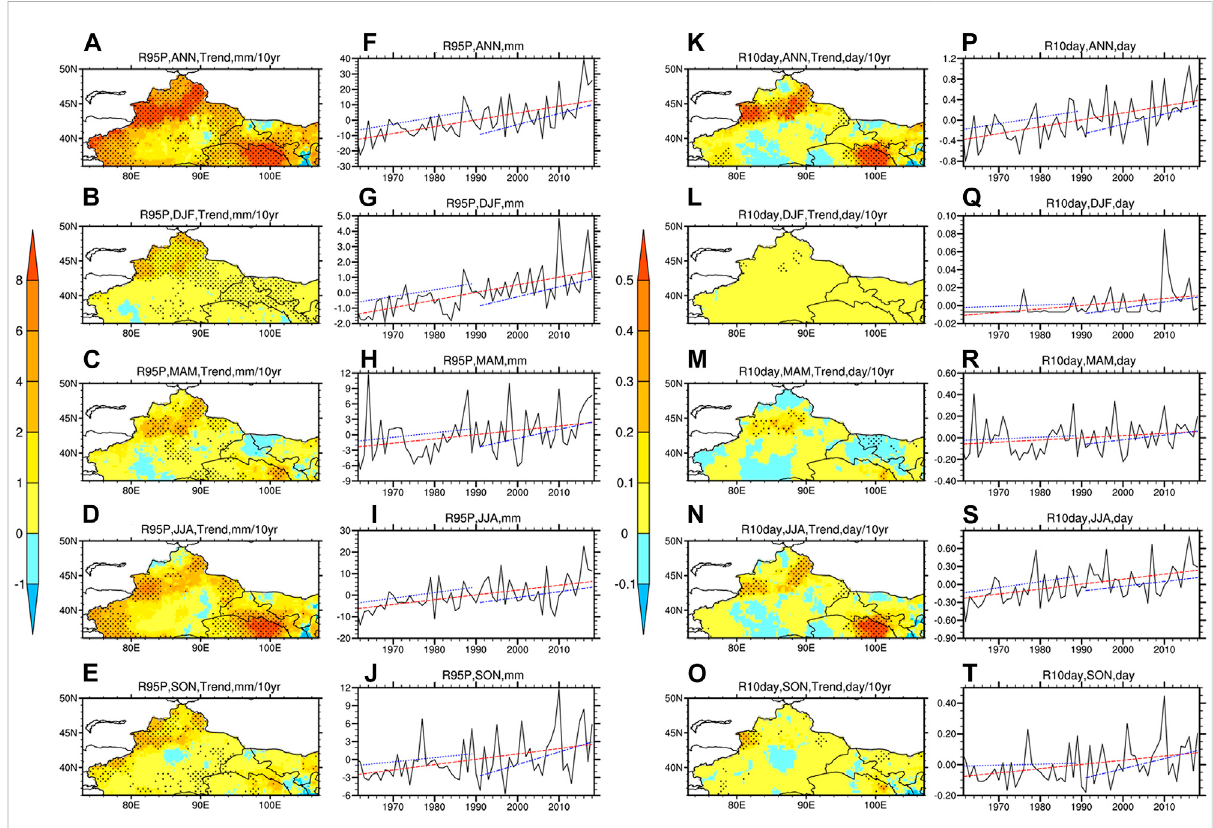
FIGURE 3 Spatial distribution of annual and seasonal precipitation trends from 1961 to 2018. (A – E, K – O) , the black dots are the grids that passed the 0.05 level signi fi cance test) and regional mean precipitation anomalies (F – J, P – T) in the ANWC. The red and two blue lines represent the overall trends from 1961 to 2018, 1961 to 1990, and 1990 to 2018,